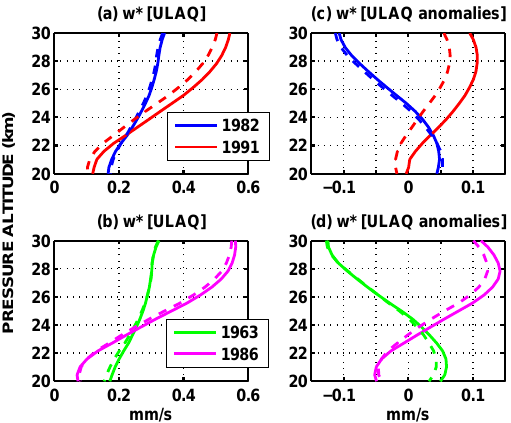
Figure 8. Left panels ( a ,b) ULAQ-CCM residual mean vertical velocity profiles (mm/s) from 20 to 30 km altitude, averaged between 15 ˝ S and 15 ˝ N latitude; panel ( a ) time average during 1982 (El Chichón, W shear, blue) and 1991 (Pinatubo, E shear, red); panel ( b ) time average during 1963 (Agung, W shear, green) and 1986 (Ruiz, E shear, magenta). Right panels ( c , d ) as in panels ( a , b ), but for the anomalies of the residual mean vertical velocity, calculated with respect to the 1960–2000 average. Solid/dashed curves are for VE and REF simulations, respectively.